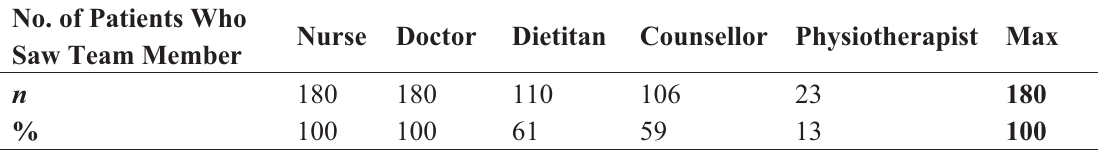
Table 8. Number and proportion of patients seeing each healthcare professional.